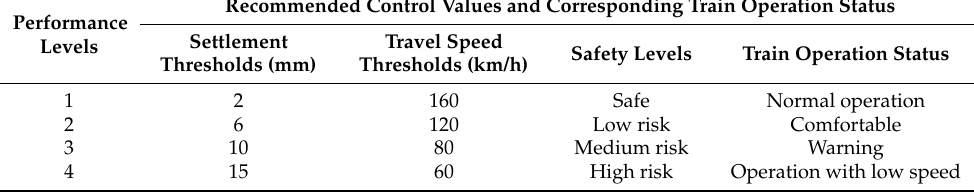
Table 2. Operation safety control of a high-speed railway system concerning subgrade settlement [51,52].